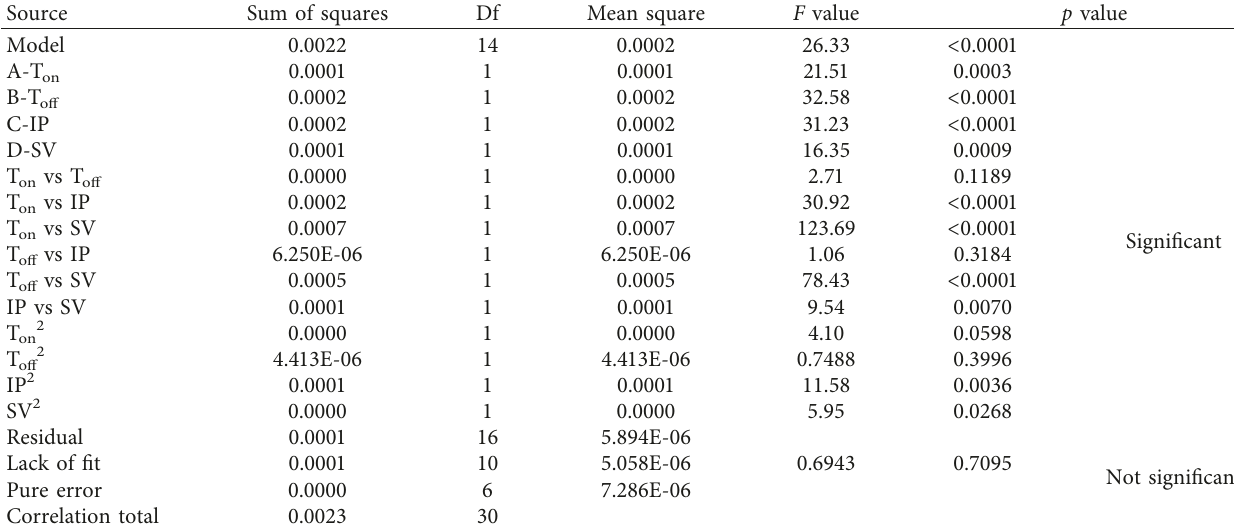
Table 4: ANOVA results for the response of kerf width.